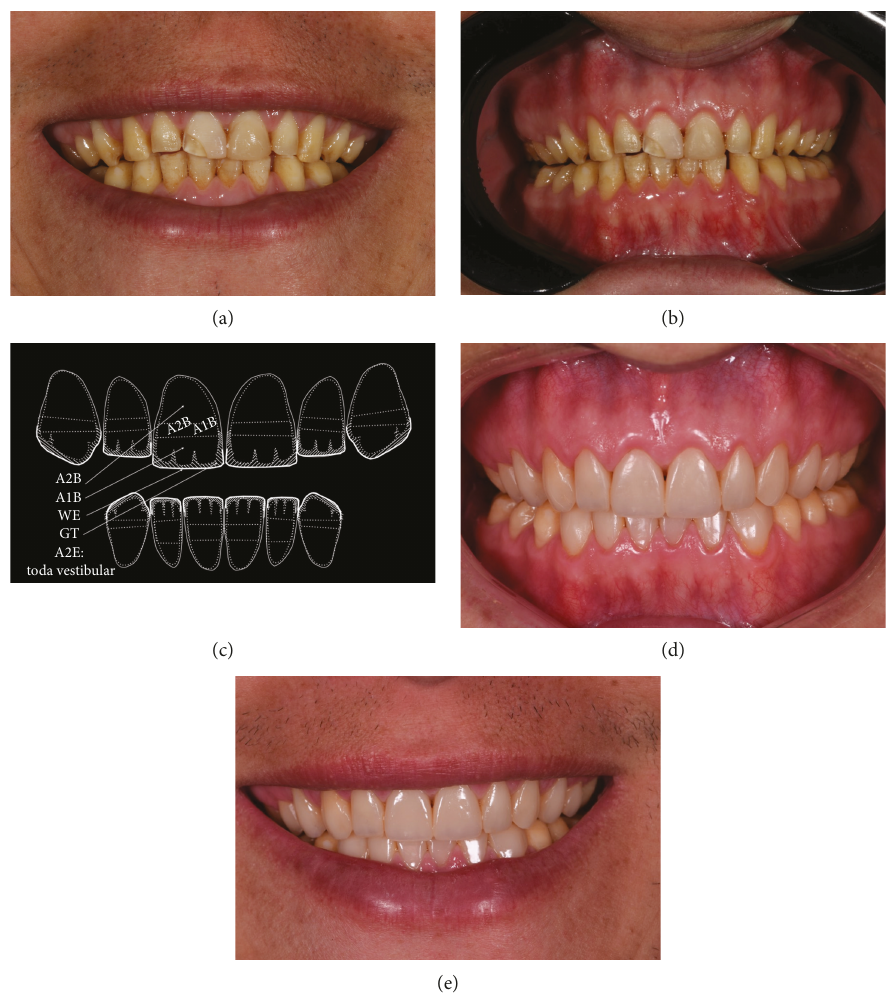
Figure 1: (a, b) Initial appearance of patient ’ s teeth with amelogenesis imperfecta. (c) Selection of resin colors. (d, e) Restorations after occlusal adjustment and approximate view of restorations after fi nal